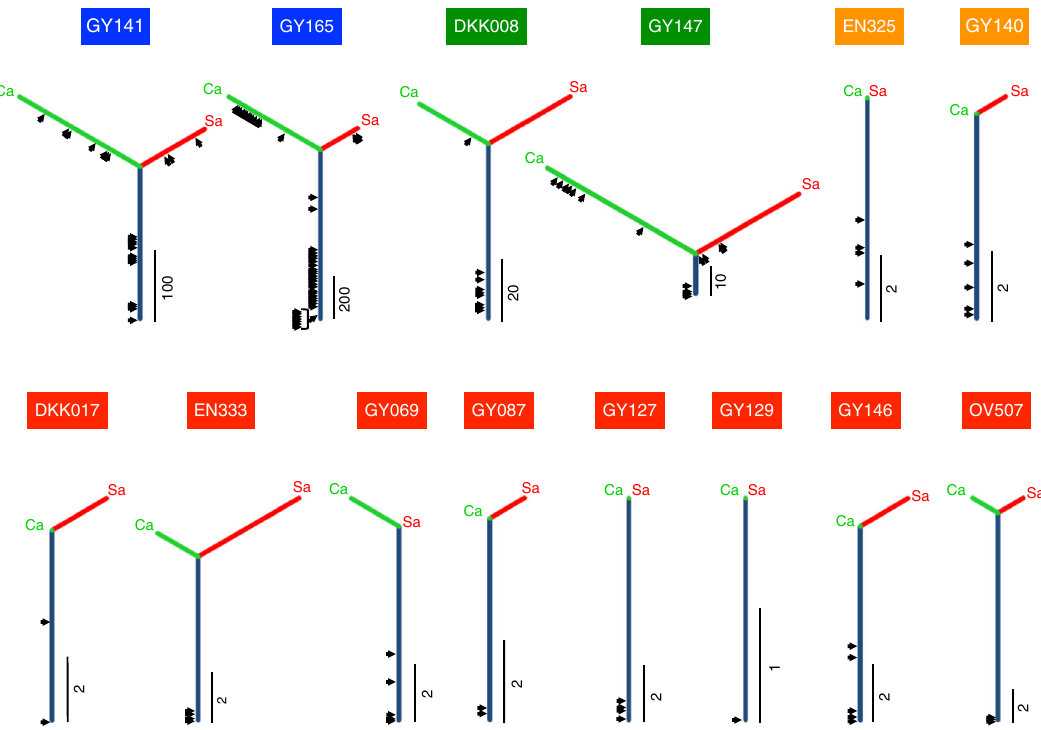
Fig. 5 Clonal evolution in the carcinoma and sarcoma elements inferred from SNVs/indels based on the 596-gene panel. Phylogenetic trees are used to represent genetic similarity of the carcinoma and sarcoma components in the primary tumor. A trunk (navy) and a branch (yellow green; carcinoma and cherry color; sarcoma) represent shared and private mutations, respectively. The length of the trunk/branch is proportional to the number of SNVs and indels, and an index beside each tree indicates the number of base pairs. The timing of driver mutation acquisition is shown with an arrow. A case ID is shown on a tree with the color indicating the genomic aberration subtype: blue, POLE; green, MSI; red, CNH; and orange, CNL). Ca, carcinoma; Sa,